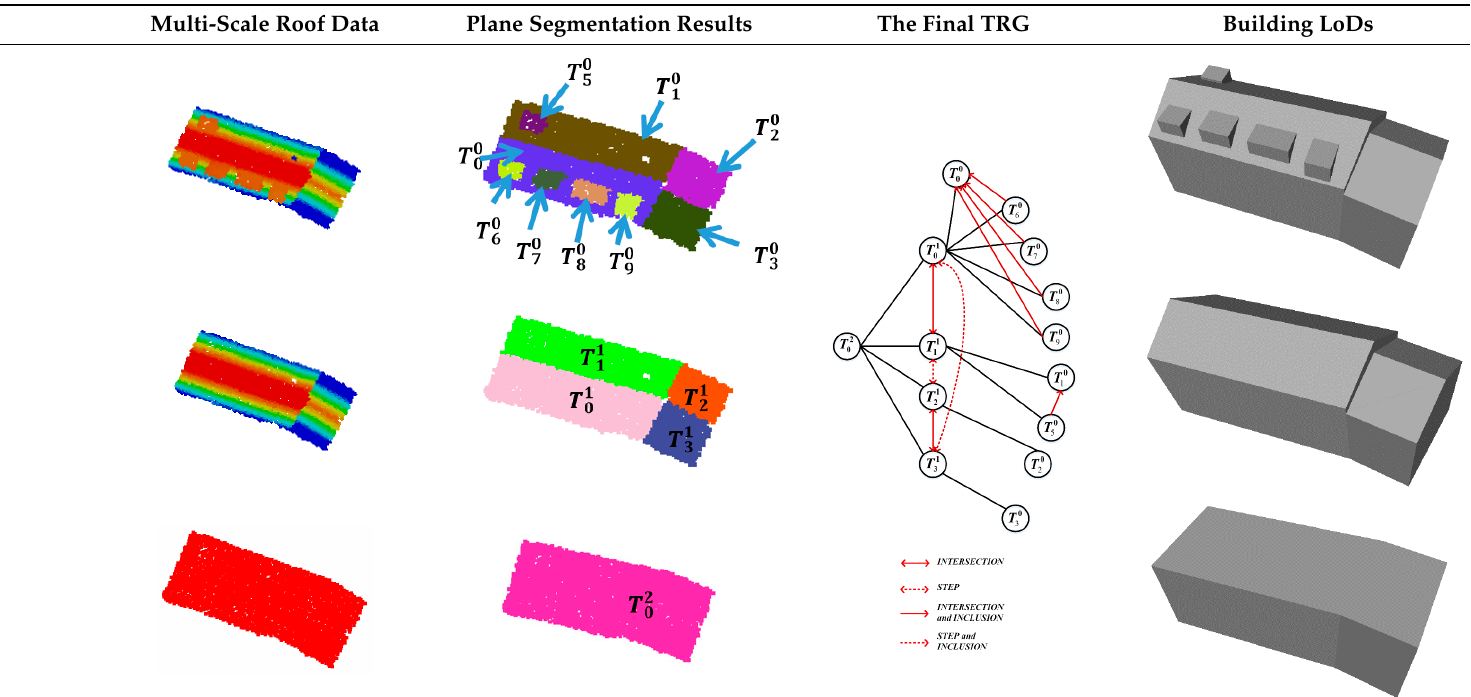
Table 3. Second example of generating the LoDs for a building with gable roofs and dormers.